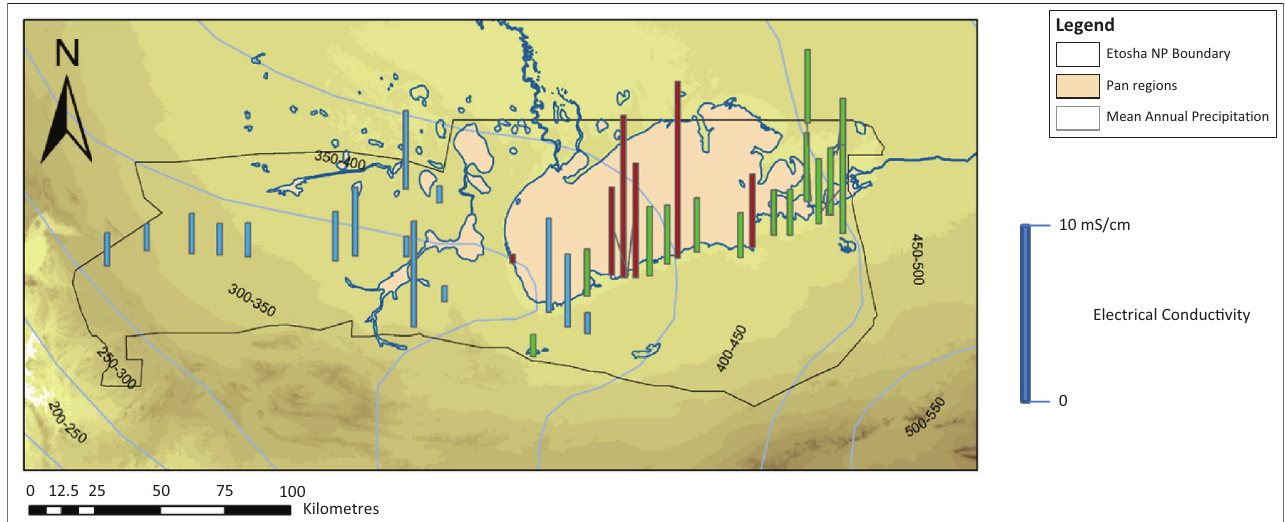
FIGURE 5: Spatial distribution of EC (mS/cm) for different water point types in the Etosha National Park, May 2013. (Possible instrument error as uncalibrated spare multi- parameter meter had to be used for all the south-north transect points, 10 May 2013.)